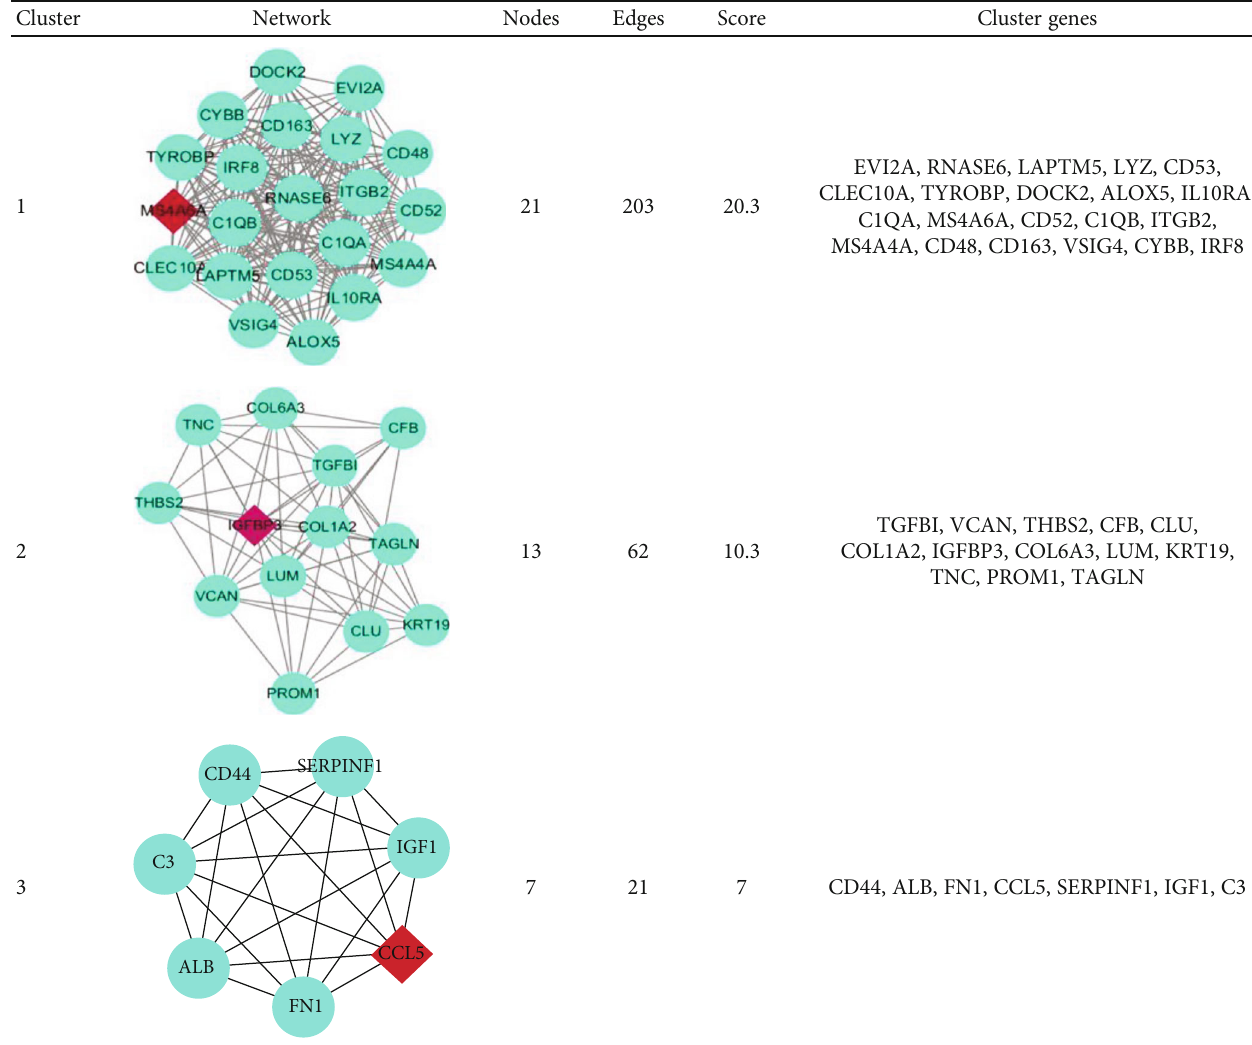
Table 1: The most signi fi cant clusters of common